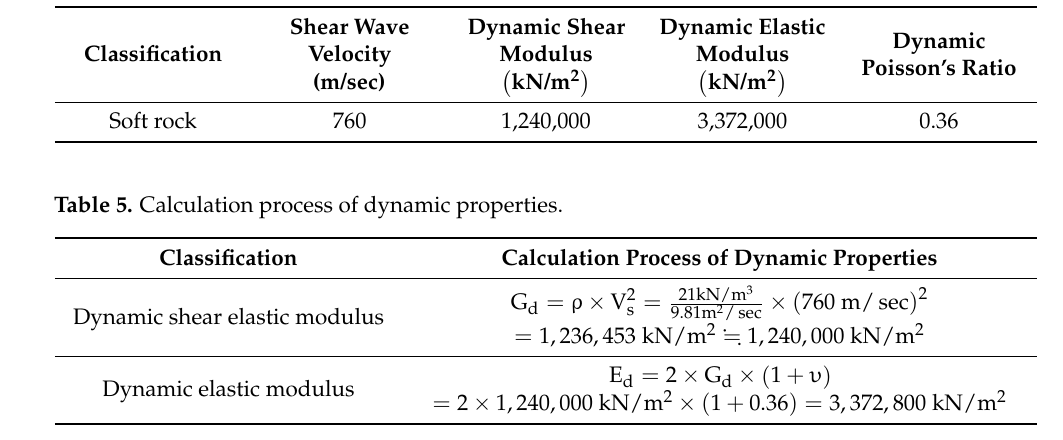
Table 4. Dynamic parameters of soft rock.